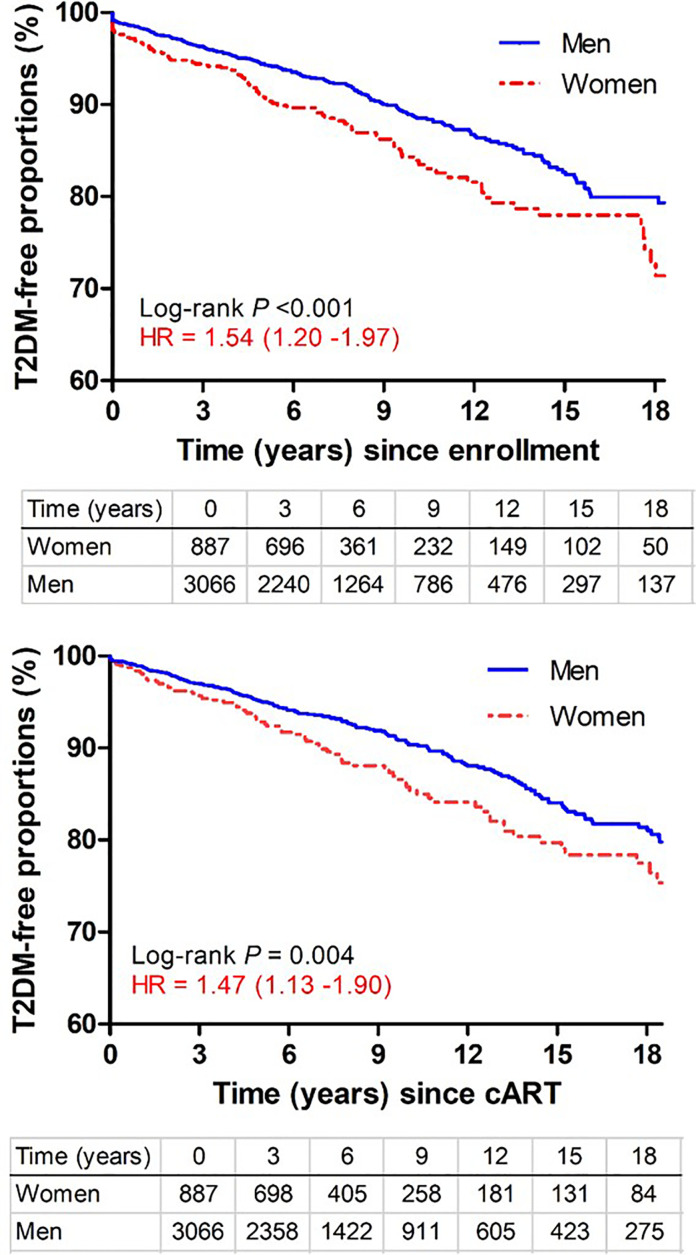
Kaplan-Meier curves showing time from study enrollment or initiation of combination antiretroviral therapy (cART) to diagnosis of type 2 diabetes mellitus (T2DM) in PLWH stratified by sex. Numbers of subjects remaining at various visit intervals (between January 1999 and March 2018) are indicated for each group (excluding 22 transgender subjects). Estimates of hazards ratios (HR) use men as the reference group.